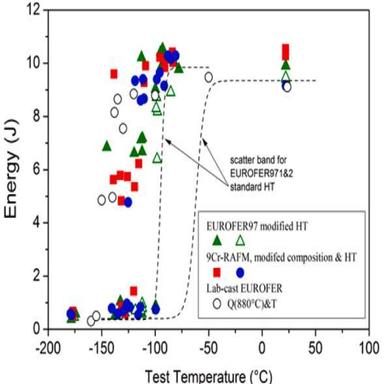
Charpy impact test data (KLST) for optimized RAFM steels in comparison to EUROFER97 1 & 2 and standard heat treatment (HT); a) modified HT (triangles): double austenized and tempered commercial EUROFER in L-T (full) and T-L (open) orientation; b) modified composition and HT : double austenized and tempered EUROFER with high Ta (square) and low Ta (circle) content.